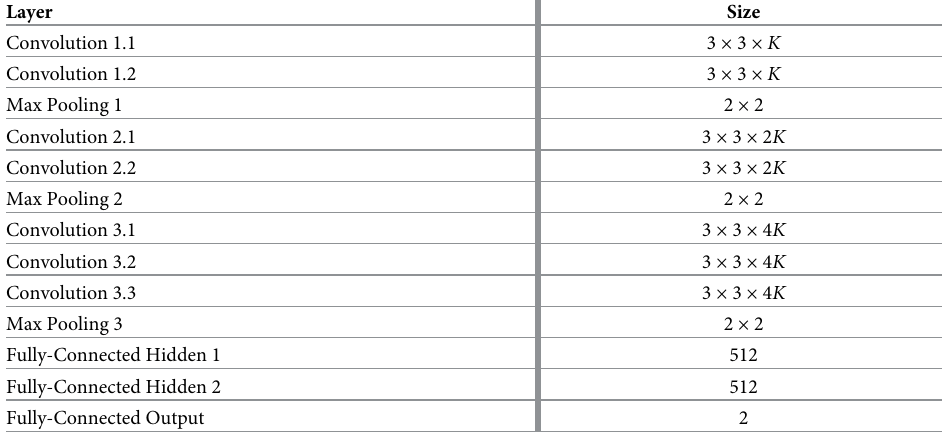
Table 2. Architecture of our convolutional neural network classification model. K denotes the number of filters in the first stage of the convolutional layers.